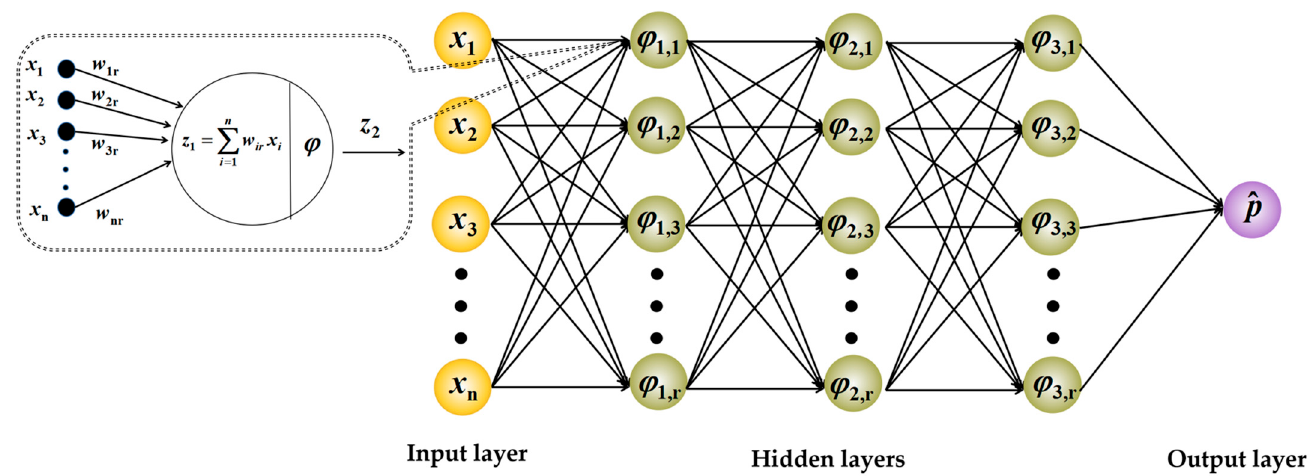
Figure 2. Structure diagram of BP-ANN.